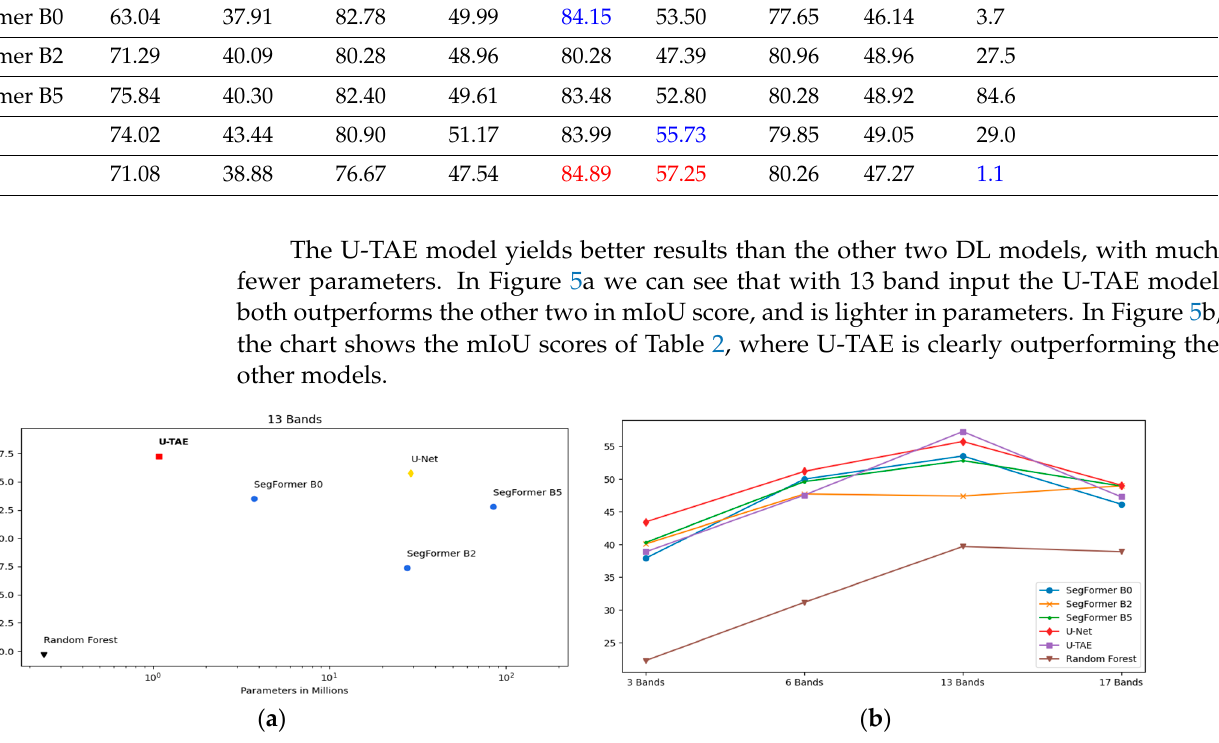
Figure 5. ( a ) The mIoU score for each model in regard to its parameters. ( b ) The effect of band input on each model’s mIoU score. The highest overall result is achieved by U-TAE.